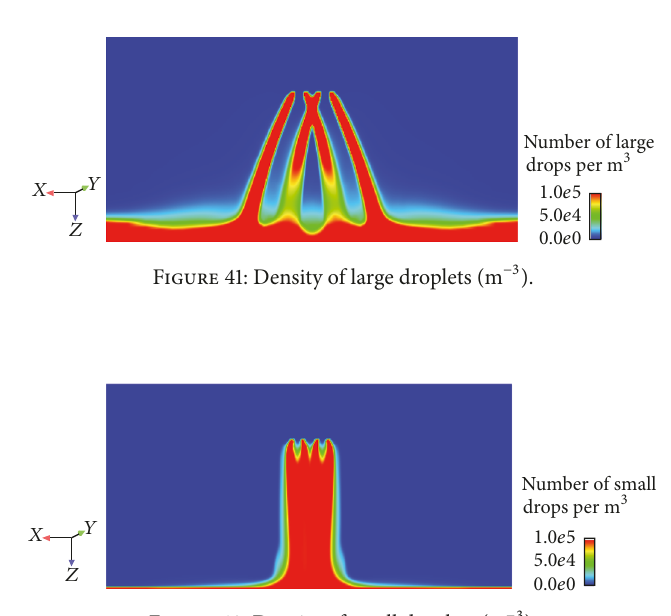
Figure 42: Density of small droplets (m −3